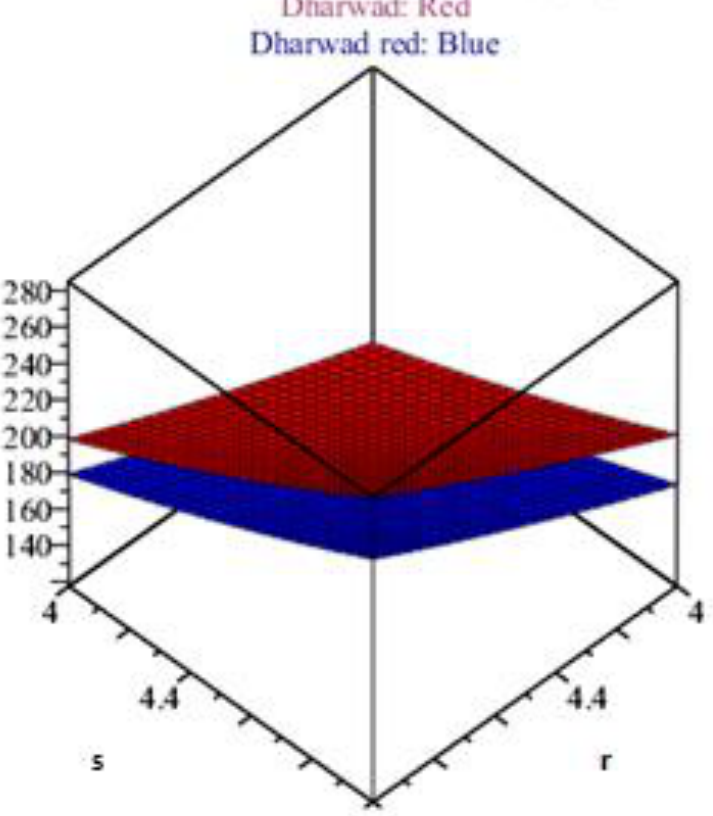
Figure 6. Dharwad and Dharwad red invariants for cloud network.